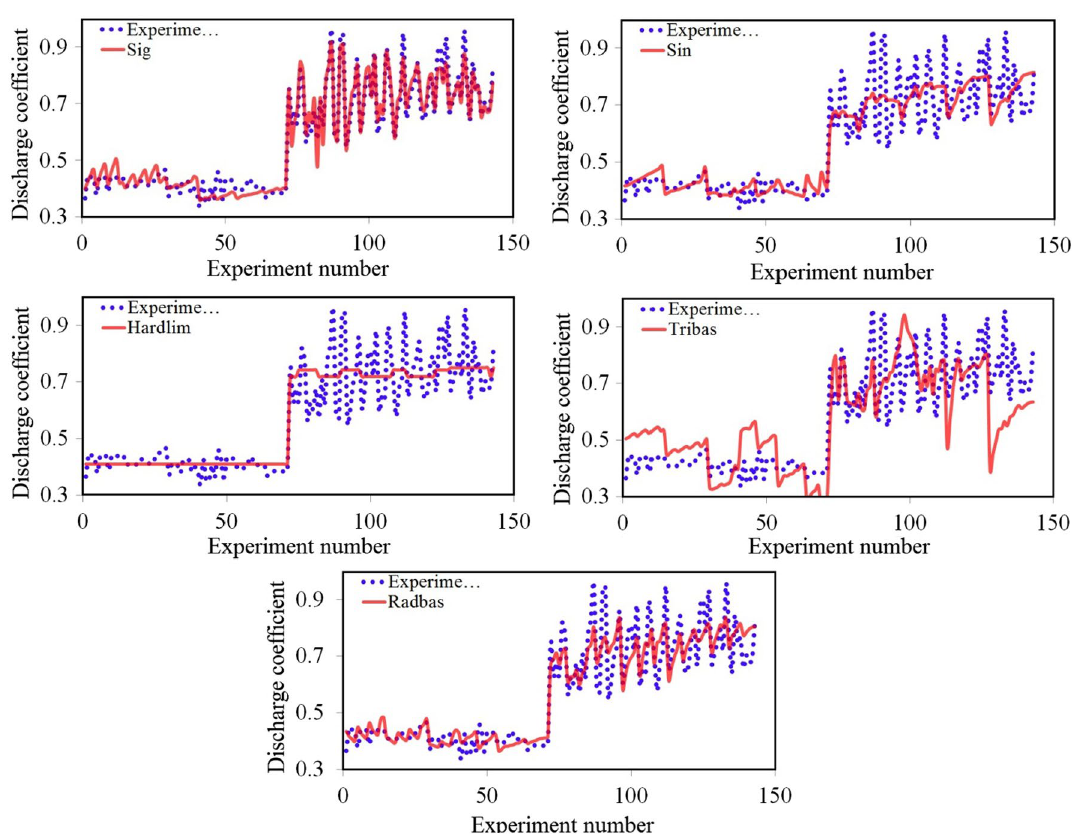
Fig. 6 Comparison of observed and experimental discharge coefficients with different activation functions of SAELM